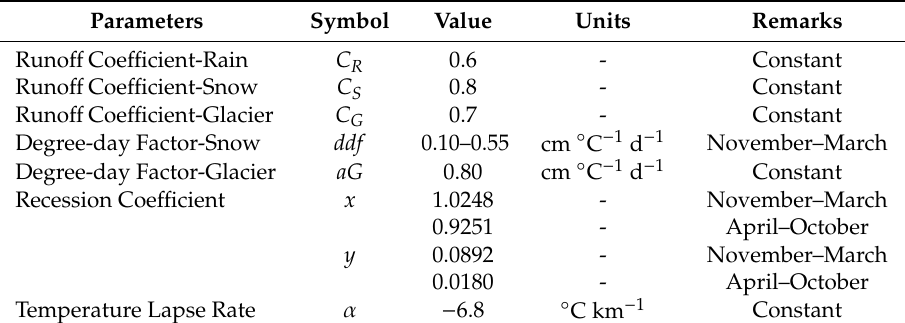
Table 1. SRM + G model parameters for Universidad Glacier